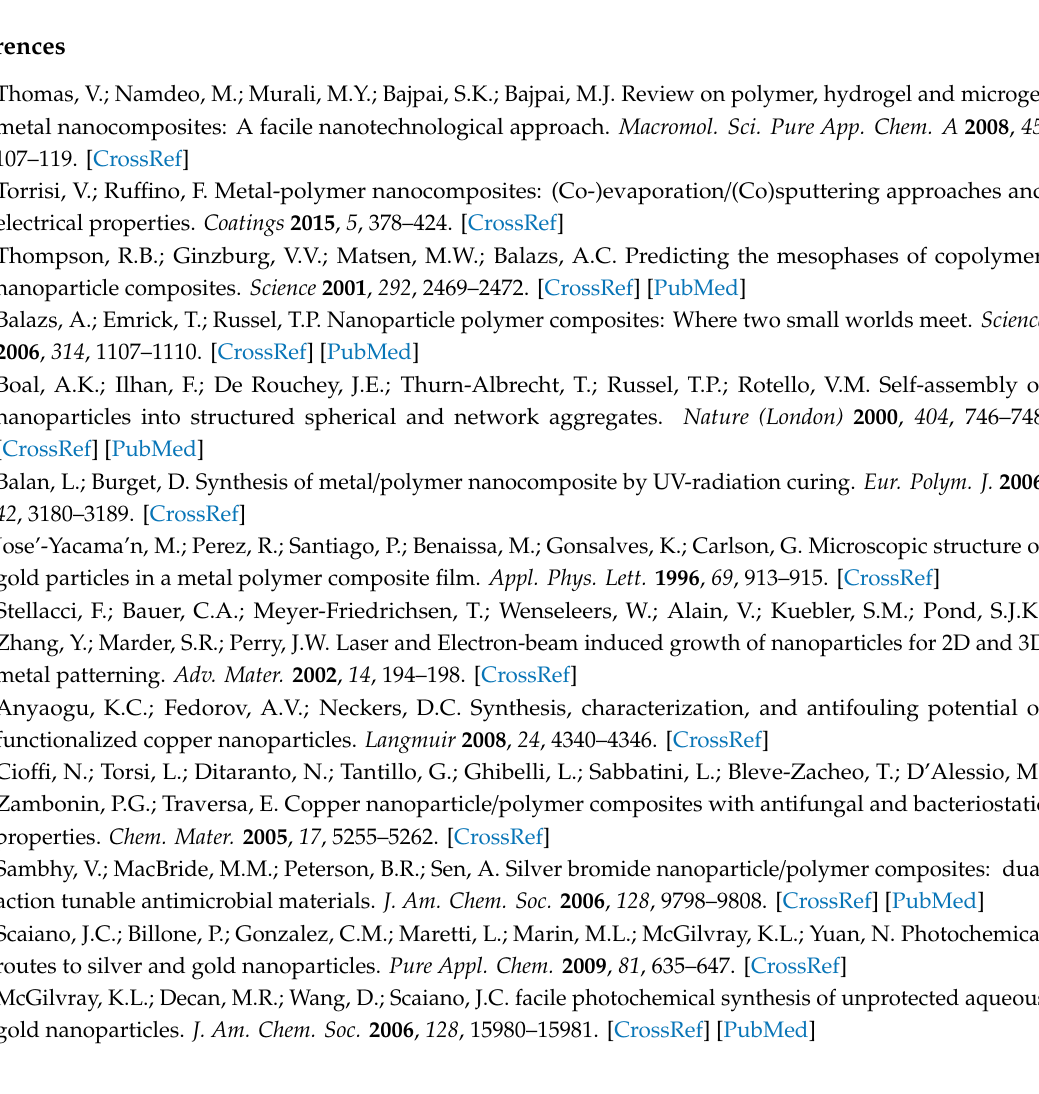
Figure S1: Mass spectrum of the ligand (HL). Figure S2: H1NMR spectrum of the ligand (HL). Figure S3: IR spectrum of the ligand (HL). Figure S4: IR spectrum of the copper complex. Figure S5. DTA, TGA and DrTGA of the ligand (HL). Figure S6: Cyclic voltammogram of HLCuCl in acetonitrile. Figure S7: Photoluminescence of HLCuCl in DMF. Figure S8. Evolution of the absorption spectra of irradiated mixtures ( λ irr = 419 nm). Solution: HLCuCl 0.05 wt% and gold chloride 4wt% dissolved in 25 mL of